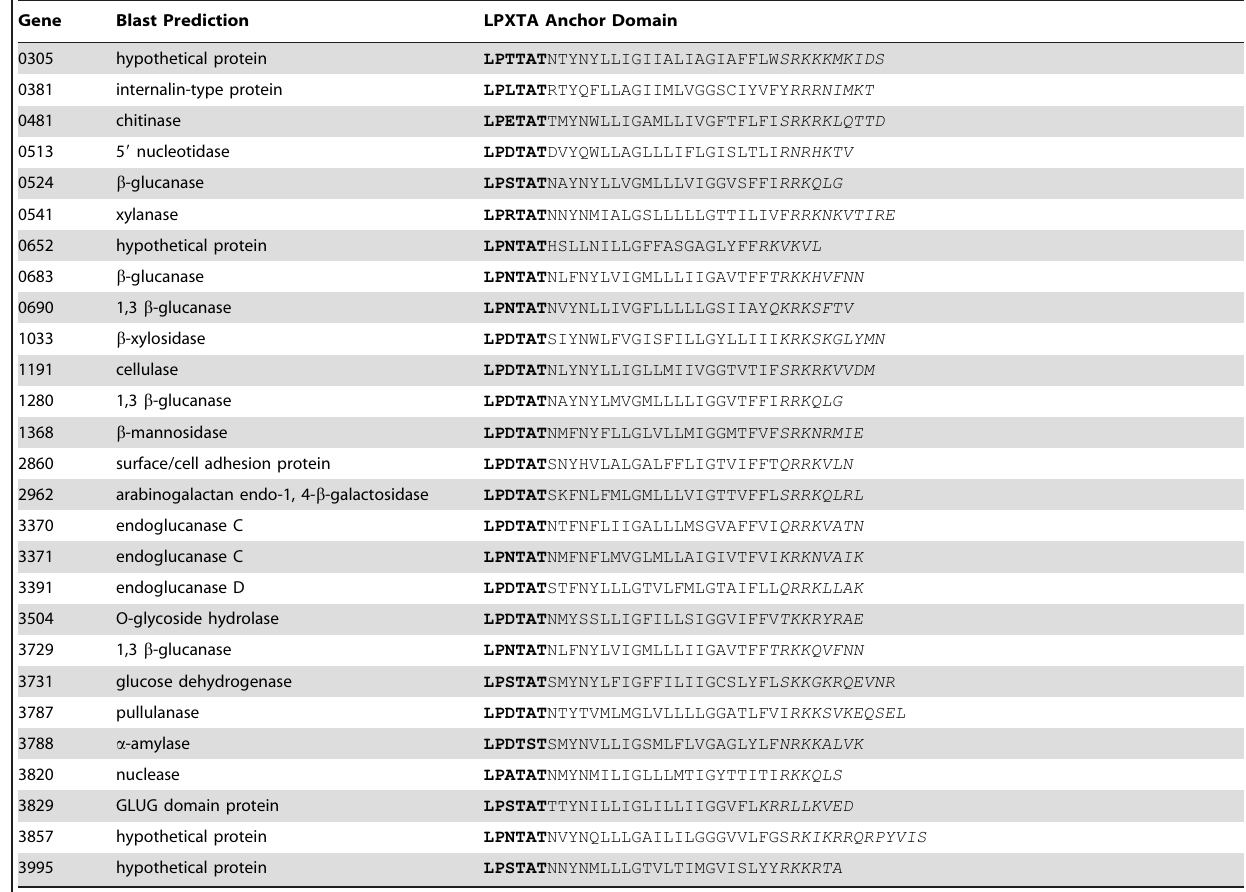
Bold : LPXTAT domain ; underline: membrane-spanning region ; italics: intracellular positive tail